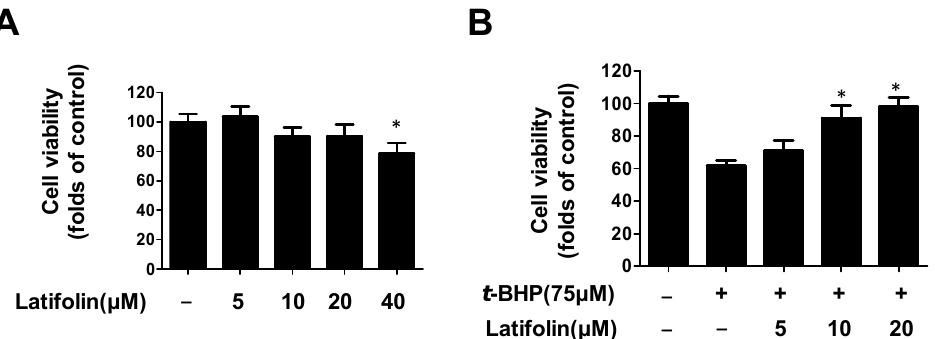
(5–20 µ M) for 3 h, followed by treatment with t -BHP (75 µ M). Cell viability was reduced by t -BHP, and it was observed that latifolin can significantly increase cell viability in a dose-dependent manner.